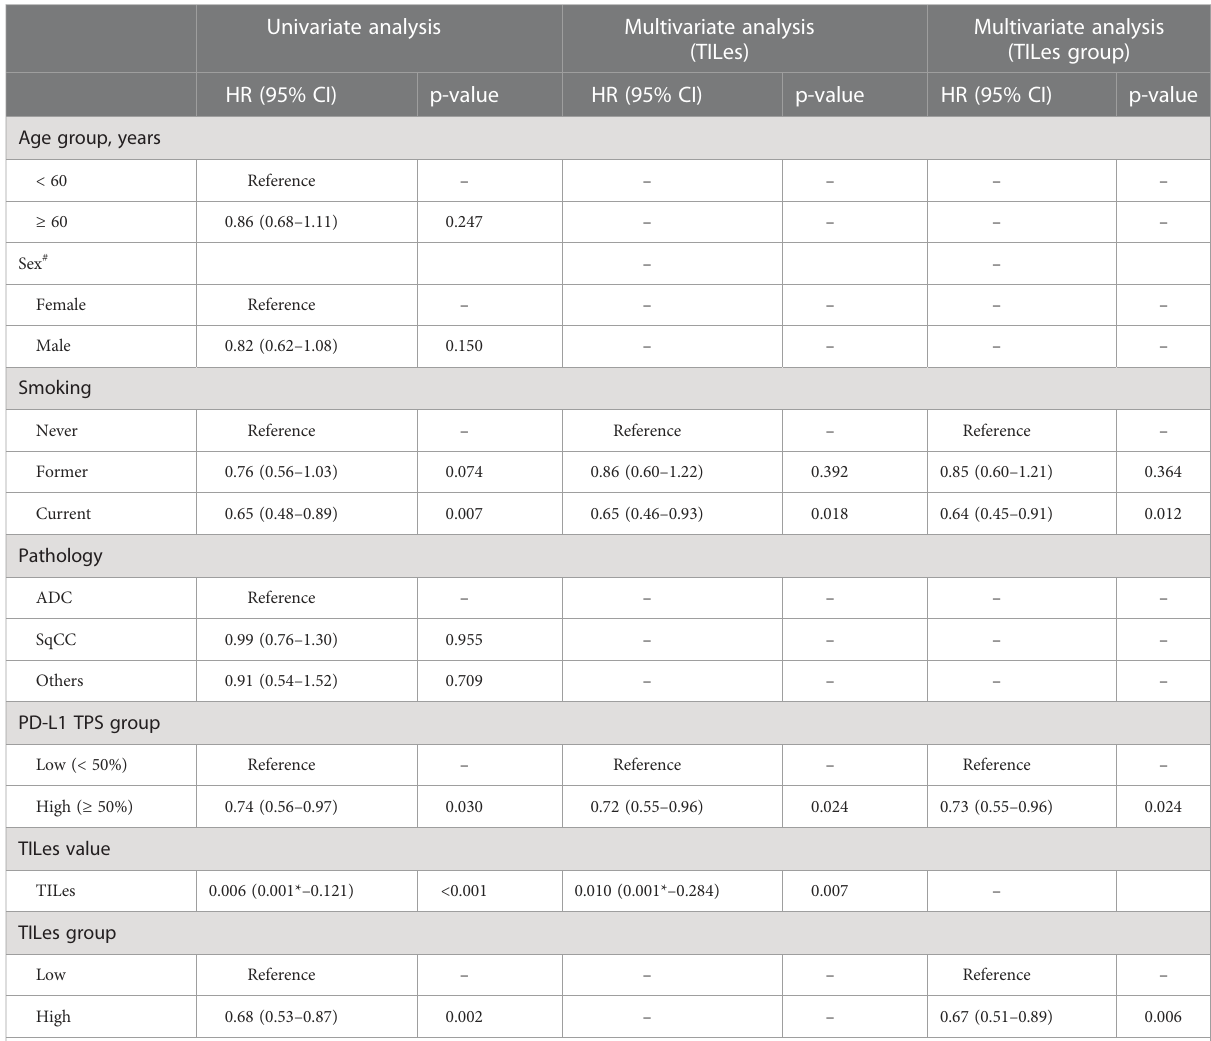
TABLE 3 Cox proportional hazards model for PFS of